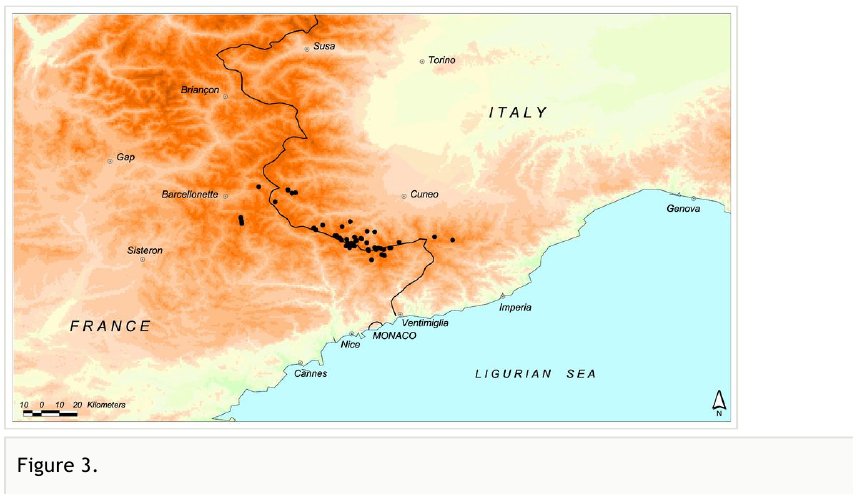
Figure 3. Distribution map of Vesubia jugorum (black